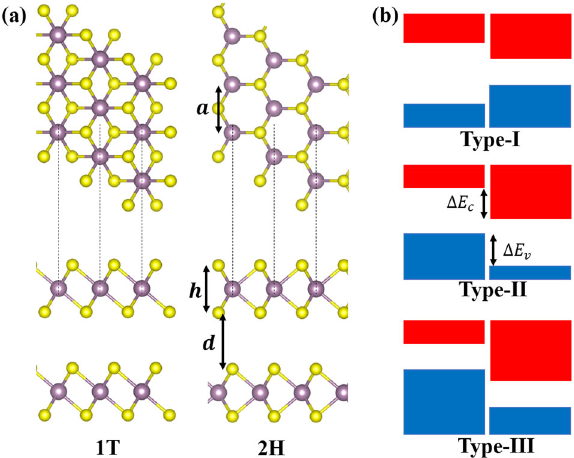
Fig. 1 Atomic structures of the monolayers and possible band alignments of the vdWHs. a Atomic arrangement of the prototypes 1T and 2H monolayers. In the fi gure the lattice constant, a , the layer thickness, h , and the inter-layer distance d , are indicated. b Possible band alignments for a two-layer heterojunction. Conduction bands are in red and valence ones in blue. In the case of type-II band alignment we have de fi ned the band offsets for the conduction and valence band, respectively as, Δ E v and Δ E c